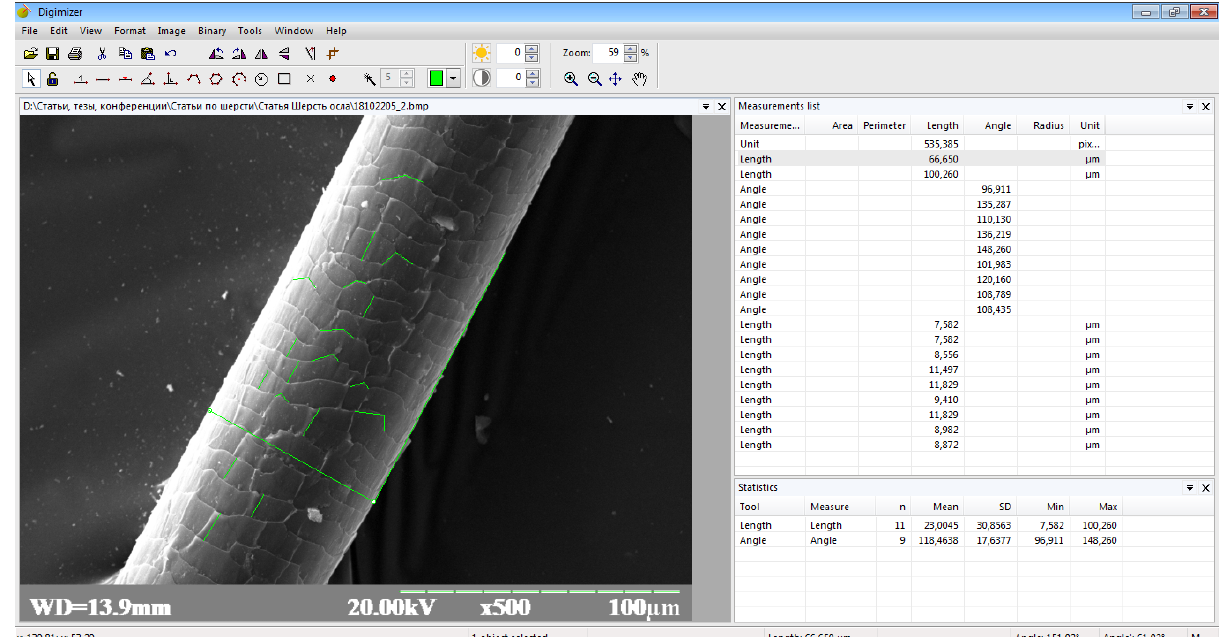
Fig. 1. Investigation of the morphometric parameters of Equinus asinus hair by digital SEM-image in programs Digimizer 4.0